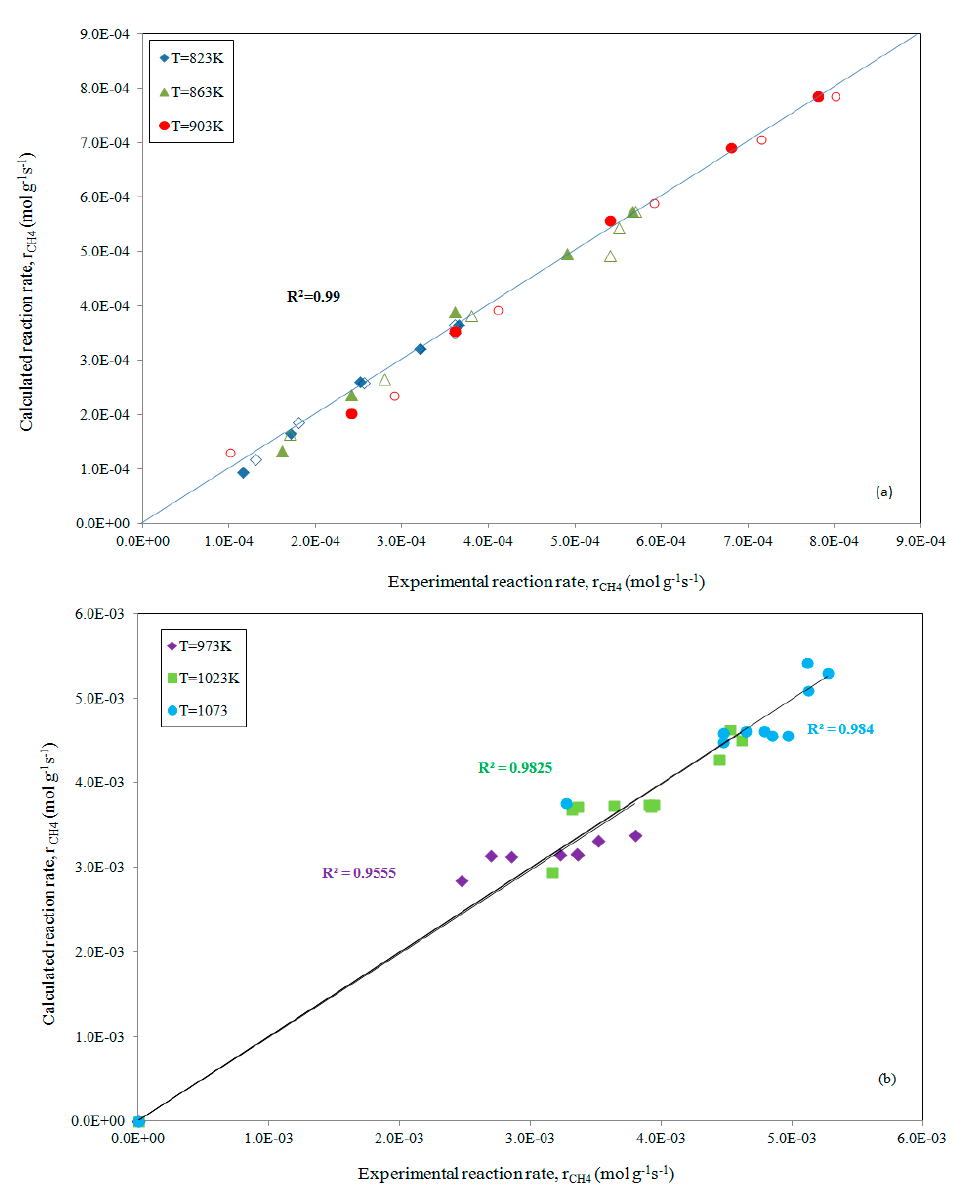
Figure 3. Parity plot for the rate of CH 4 consumption, at increasing reaction temperatures while maintaining p CO2 (full symbols) or p CH4 constant (empty symbols), comparing experimental data [15] and estimates obtained using ANEMONA after fitting Model 5 for the methane dry reforming reaction ( a ) and for experimental data from Reference [20] ( b ), respectively.